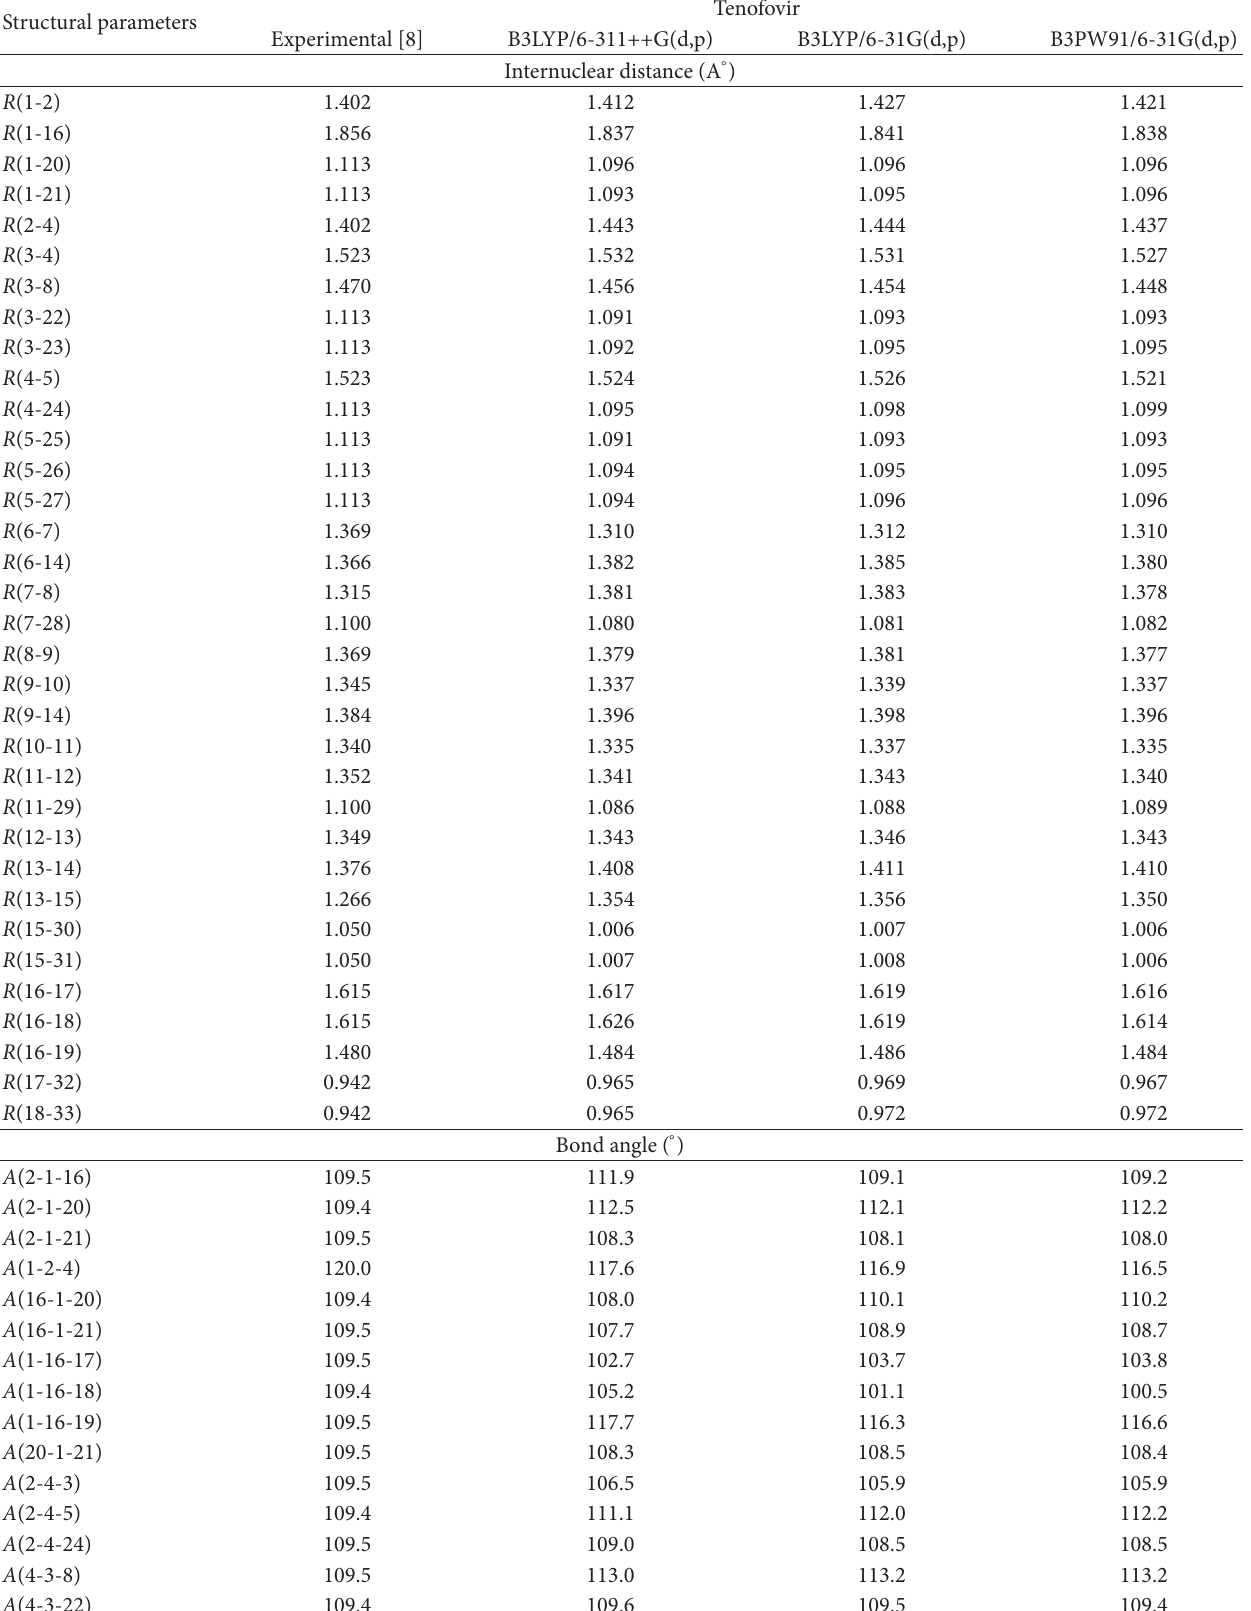
T 1: Structural parameters of tenofovir calculated by DFT